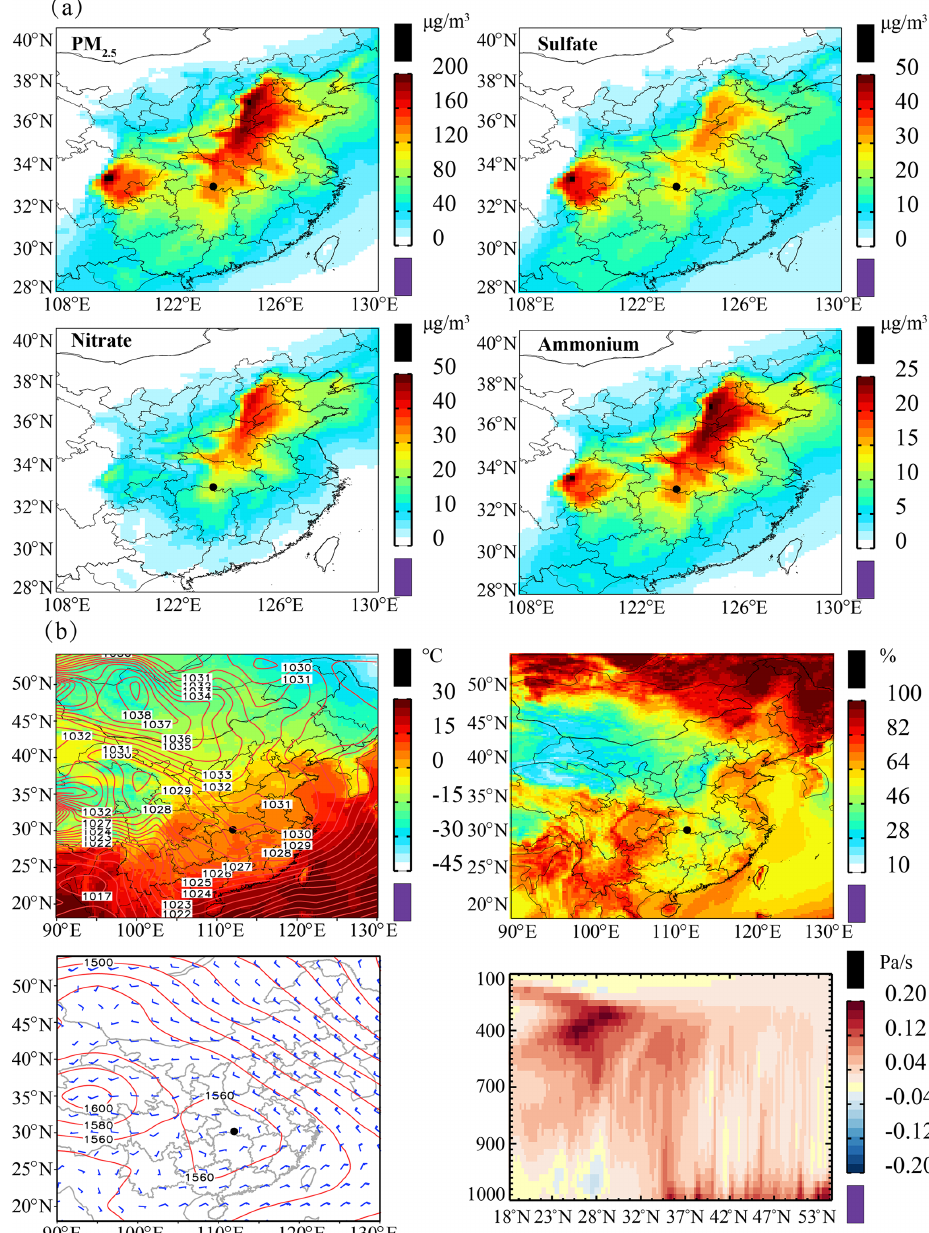
Figure 10. The same as in Fig. 7 but for A-type synoptic control (14–21 January